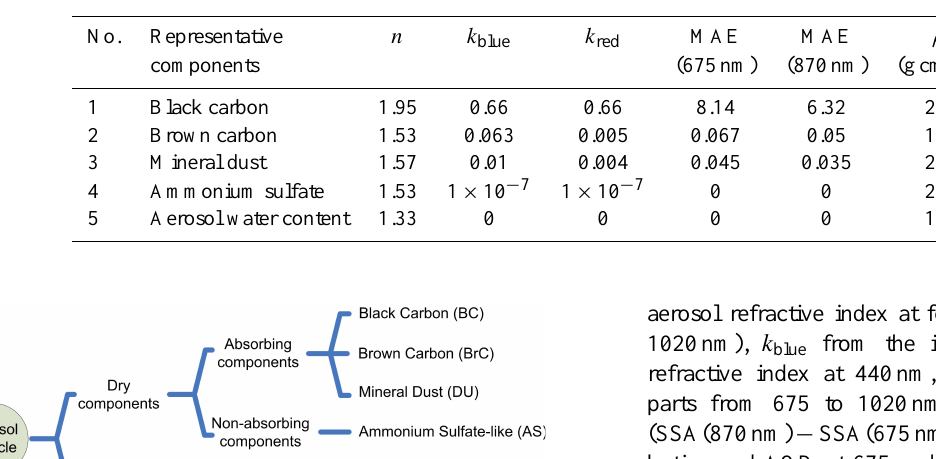
Fig. 2. Fit of the normalized sky radiance and degree of linear polarization by using the retrieved aerosol parameters for haze example on 22 February 2011 in Beijing. Table 1. Aerosol component groups and their parameters used in the retrieval of chemical fractions from remote sensing measurements. n is the real part of the refractive index, k blue is the imaginary refractive index at blue band, k red is the imaginary refractive index at red band, MAE is the mass absorption efficiency and ρ is density.